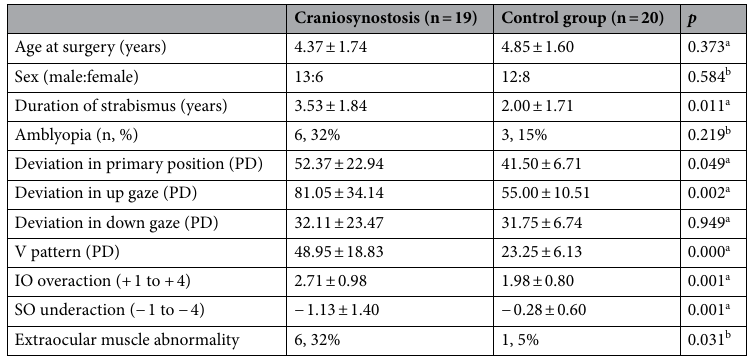
Table 1. Preoperative characteristics of the studied patients. a p value by the independent t test, b p value by the Chi-square test. PD prism diopter, IO inferior oblique, SO superior oblique.